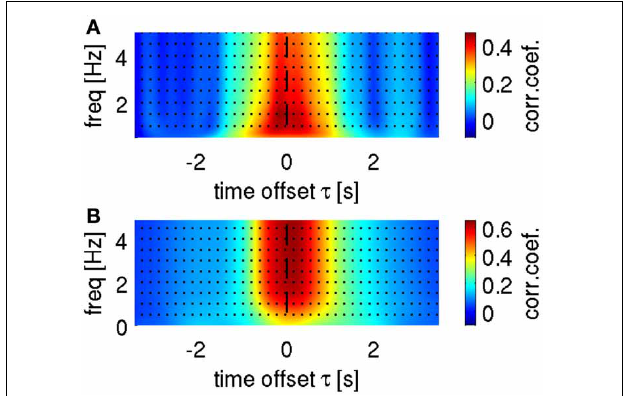
FIGURE 5 | Selection of optimal frequency ranges for velocity decoding. Representative results are shown from subject S1. (A) Search for low-pass filter cut-off frequency in time-domain ECoG LFC decoding. Mean correlation coefficient as a function of upper bound low-pass filter and a time offset τ between predictors (LFC ECoG feature vector) and decoded movement velocity. The highest correlation coefficient based on the LFC was found in the frequency range [0.1–1.5]Hz in all subjects. (B) Cumulative sum (bottom-up direction) of predicted velocity frequency components at different carrier frequencies f (FC f ), decoded using time-frequency domain ECoG FD f features (DAlg3, Figure 3 ). Mean correlation coefficient between the cumulated predictions (i.e., FC f 0 , FC f 0 + FC f 1 , FC f 0 + FC f 1 + FC f 2 , ... ) and actual velocity with different time offsets τ between predictors and movement velocity (as in A ). Decoding accuracy saturated in all subjects after including the first 5 FC f